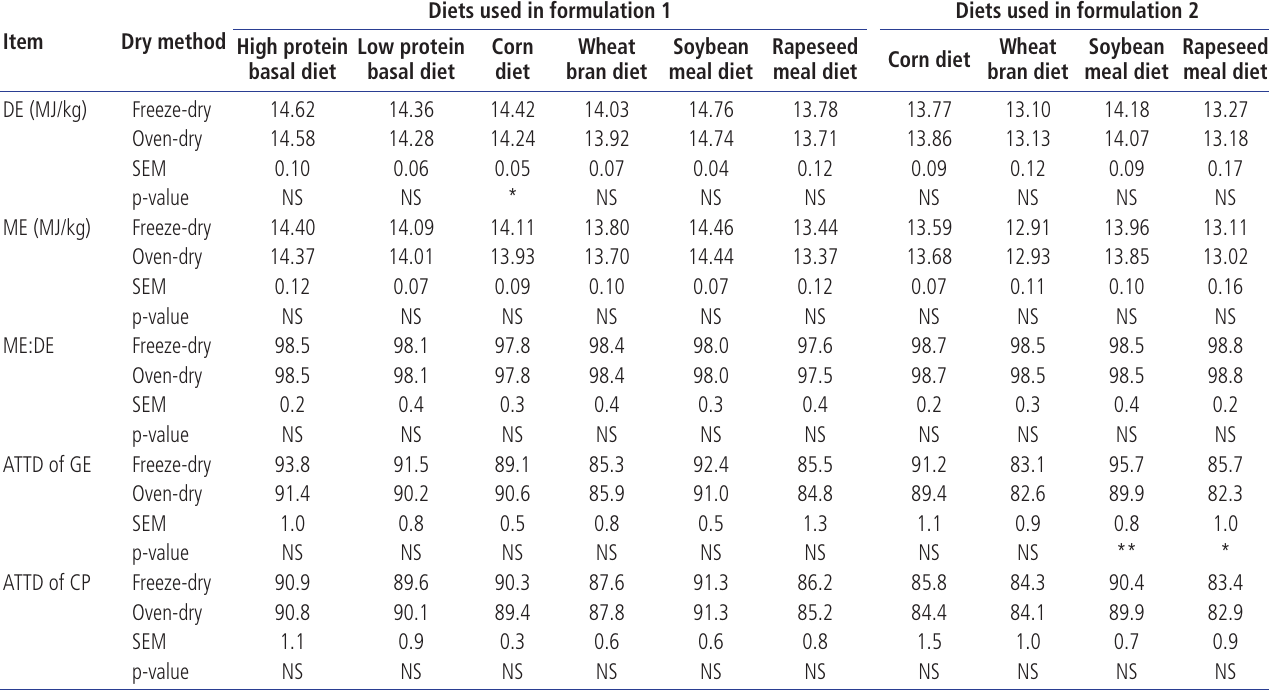
Table 7. Effects of drying methods on digestible energy (DE), metabolizable energy (ME), and the apparent total tract digestibility (ATTD) of gross energy (GE) and crude protein (CP) in experimental diets fed to growing pigs (% as fed basis) 1)